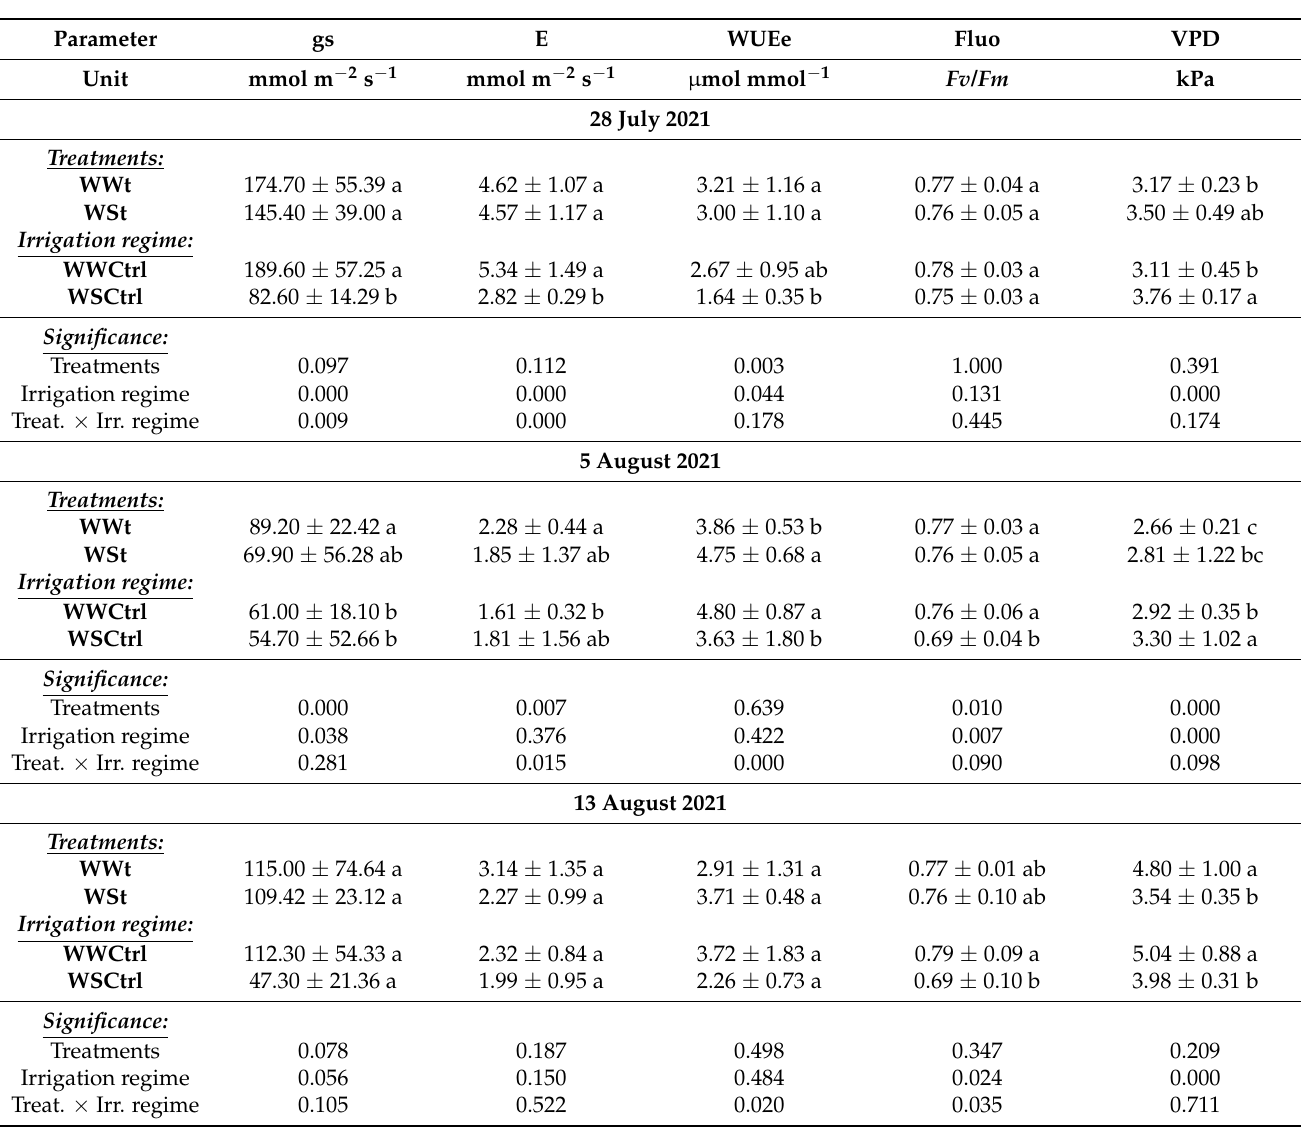
Table 1. Two-way ANOVA ( p < 0.05) for eco-physiology parameters in Vitis vinifera (Pinot Noir cv.) treated with Zeolite (t) and untreated plants (Ctrl), under two irrigation regimes (WW, well-watered; WS, water-stressed). Values are the mean of the data of each parameter, considering treatments (zeolite and Ctrl) and irrigation regime (Irrig. Regime) as factors. In the last 3 rows is indicated the significance. Other abbreviations: stomatal conductance (gs), transpiration (E), water use efficiency (WUE), fluorescence of chlorophyll (Fluo), and vapor pressure deficit (VPD). The same letter pictured on different treatments indicates no significant difference among them (mean ± SE, n =